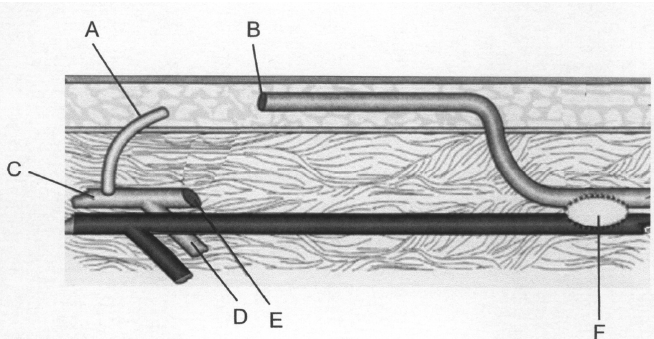
FIGURE 1 - Superficial femoral vein superficialization. A. Greater saphenous vein. B. SFV in the subcutaneous layer. C. Femoral vein. D. Deep femoral vein. E. SFV stump. F. Femoral artery – SFV anastomosis.